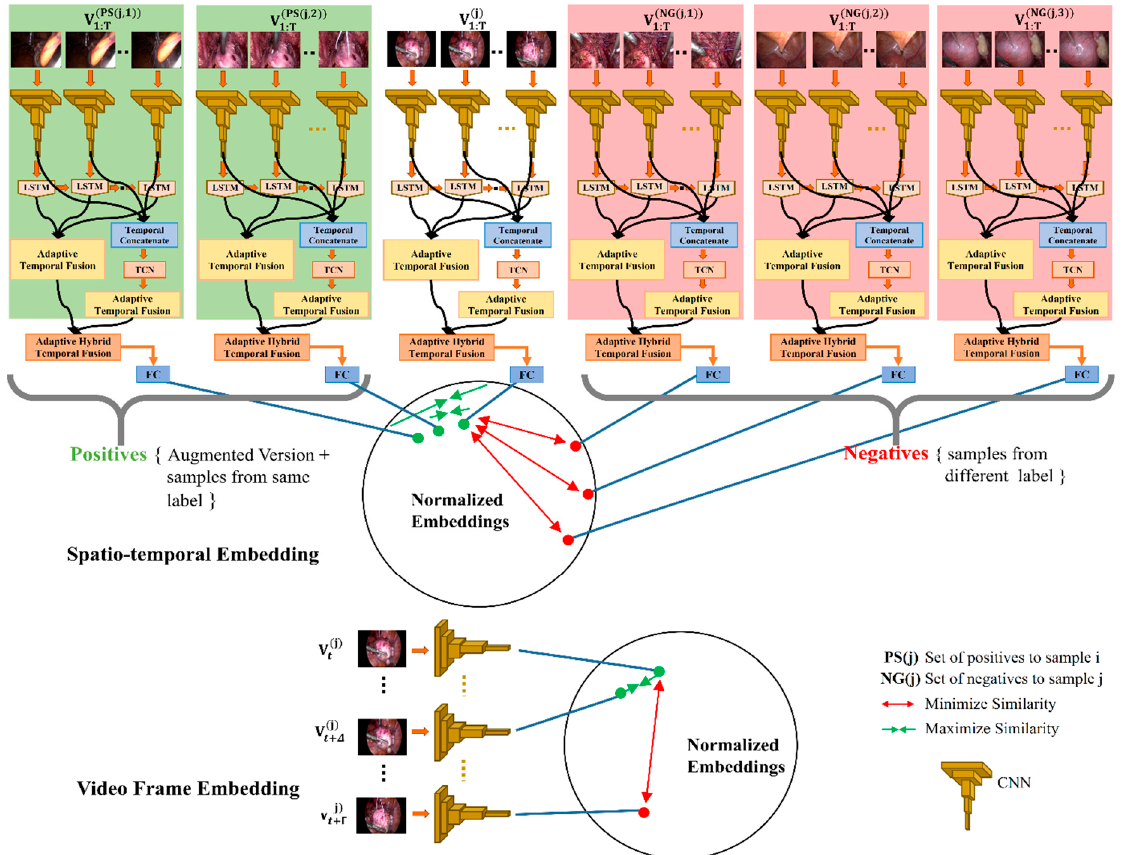
Figure 4. Proposed hybrid spatiotemporal contrastive embedding learning for surgical video.